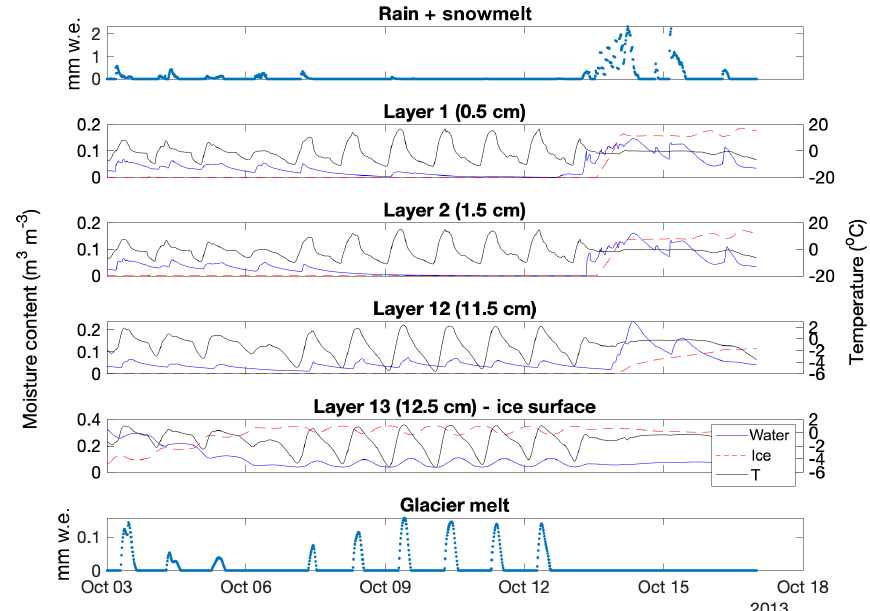
Figure 6. Time-evolving water content, ice content, and temperature of the top two and bottom two layers of debris, shown during a 2-week period when water enters the debris both at its surface (from rain and snowmelt, top panel) and at its base (from glacier melt, bottom panel). The phase of the moisture changes as a function of temperature. Note that the moisture and temperature y scales vary between the layers.